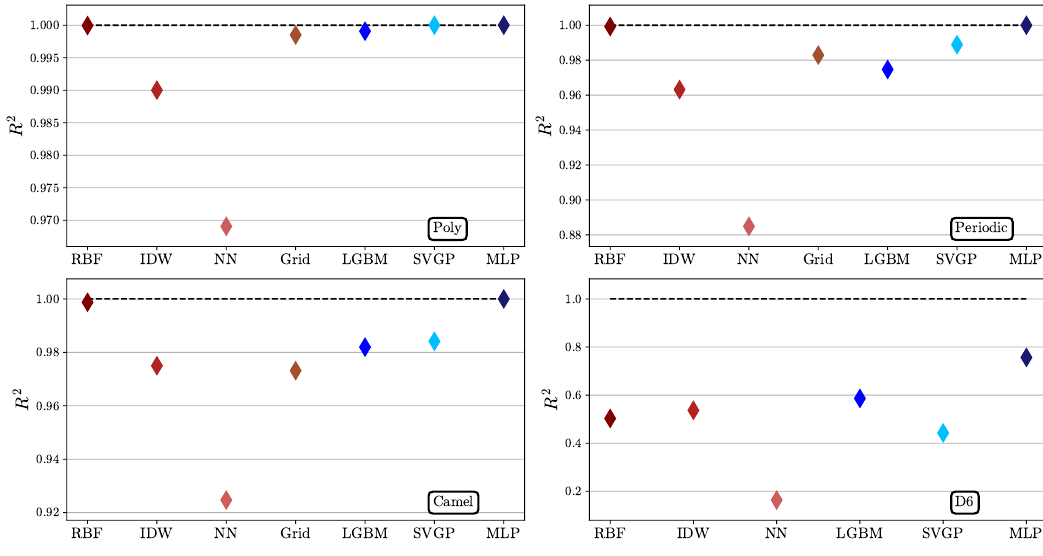
Figure 10: R 2 values in 6 dimensions for the three toy functions and